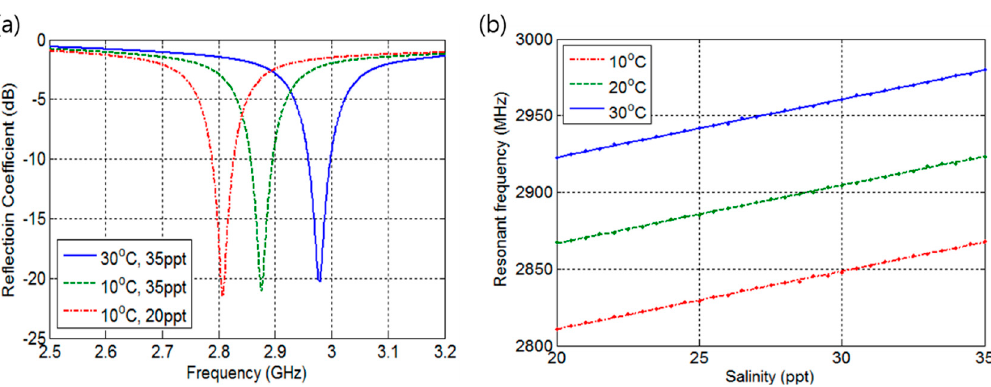
Figure 5. Simulation results. ( a ) Frequency response; ( b ) Resonant frequency according to salinity level.